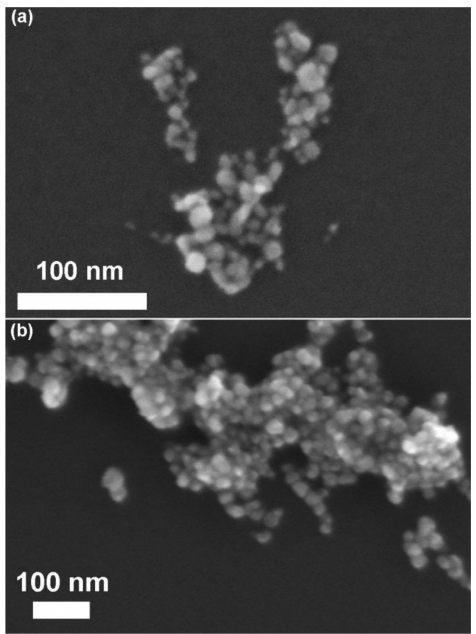
Figure 2. Field emission scanning electron microscopy (FESEM) images of pristine ZnO NCs obtained via ( a ) conventional synthesis and ( b ) microwave-assisted